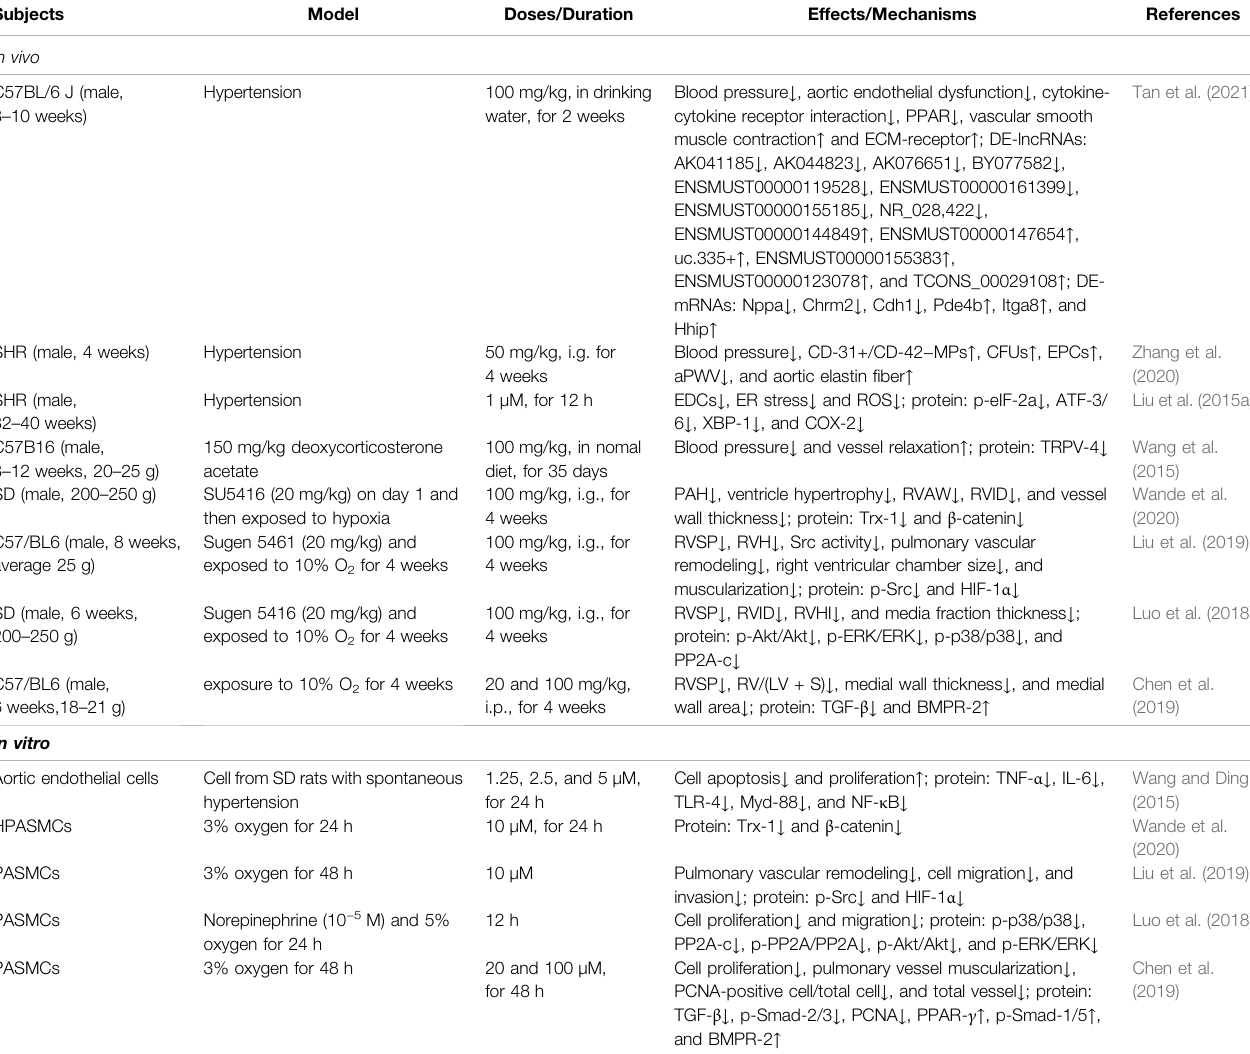
TABLE 4 | Pharmacological properties of berberine in the treatment of hypertension and PAH.